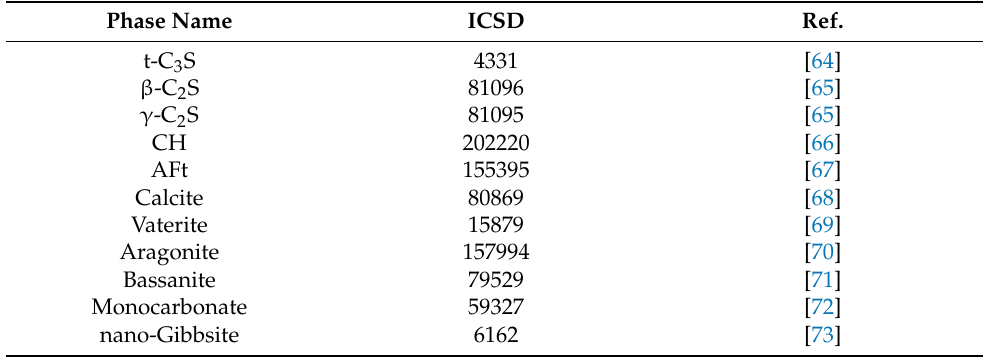
Table A1. Crystal structures used in the Rietveld quantitative phase analysis including the ICSD